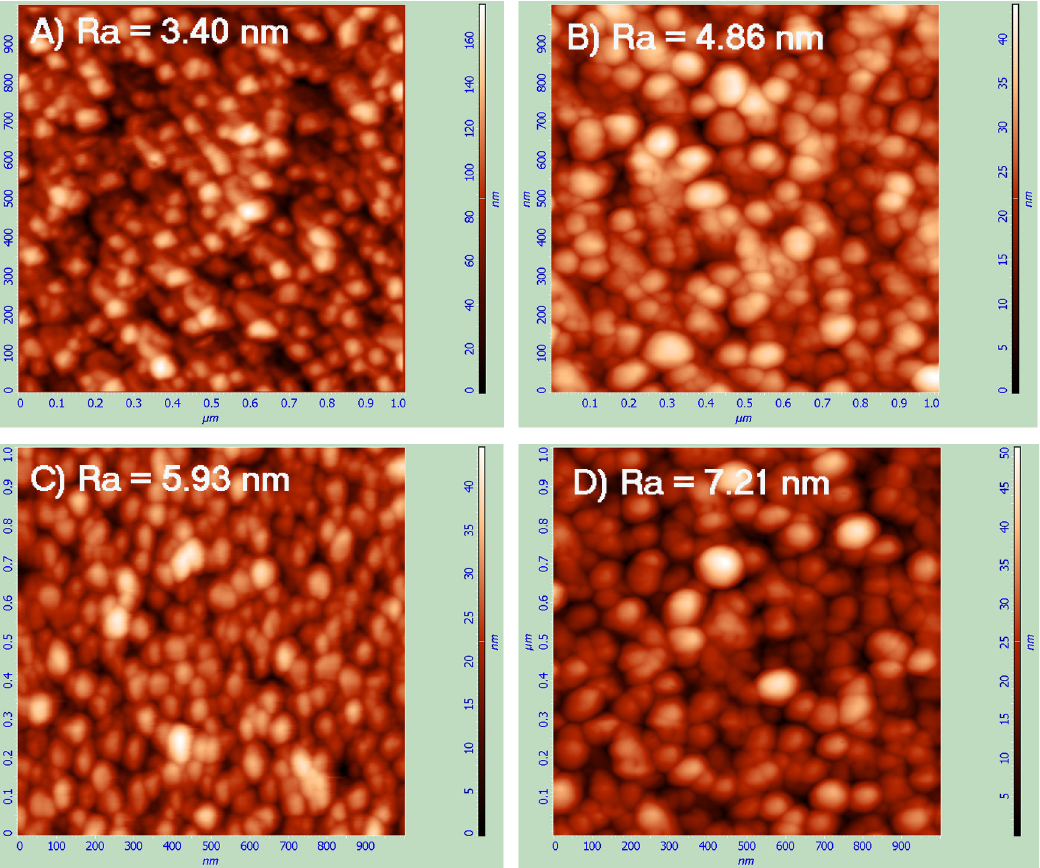
Figure 1. Surface morphology on the prominences (or on the continuous film; A , B ) and on the grooves ( C , D ) of fresh ( A , C ) and aged ( B , D ) C Microscopy (AFM).